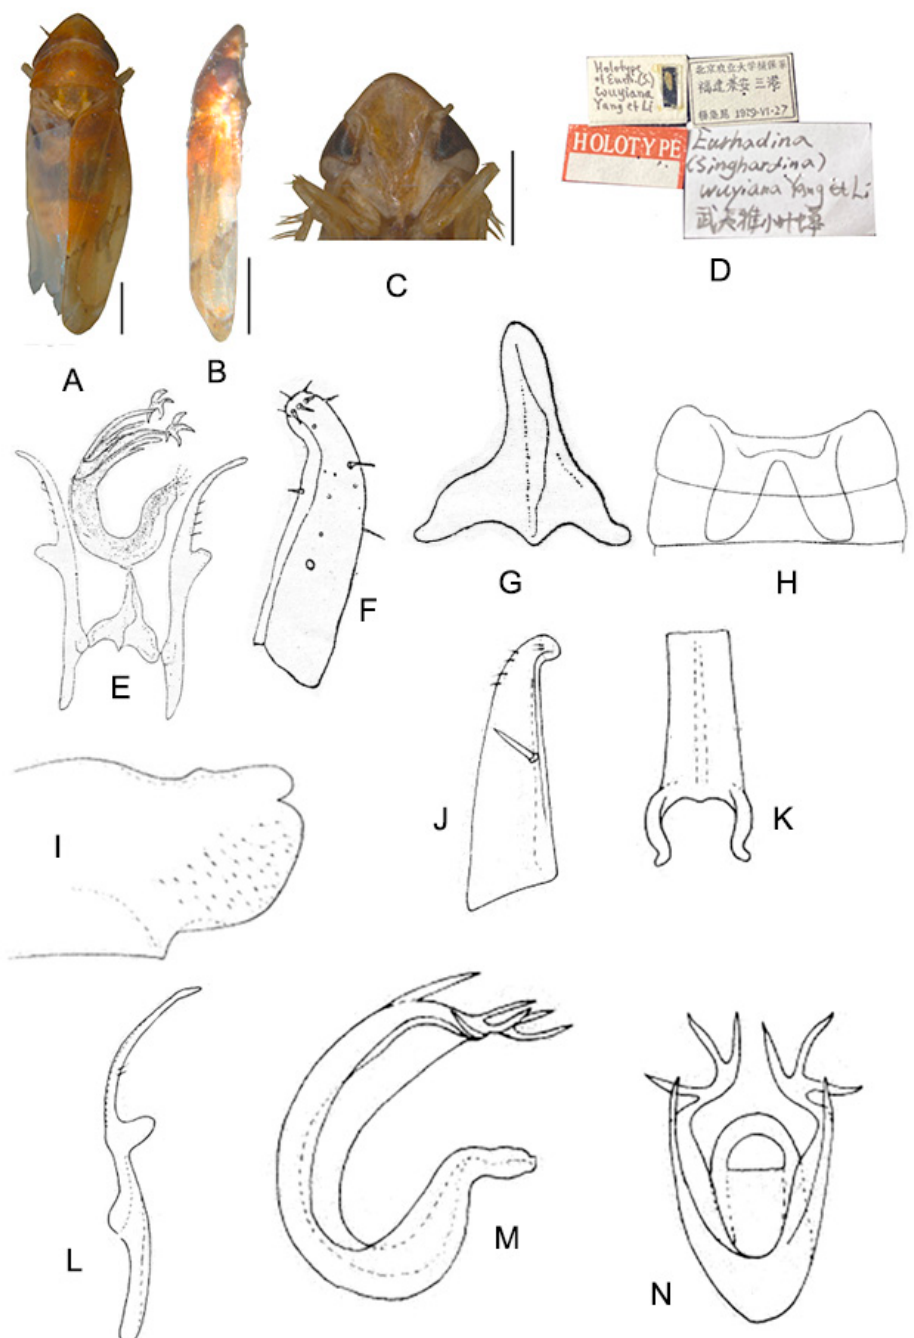
Figure 22. Eurhadina ( Singhardina ) wuyiana ( A – D : holotype; E – G : Yang et Li, 1991 [12]; H–N: Huang et Zhang, 1999 [8]); ( A ) habitus, dorsal view; ( B ) habitus, lateral view; ( C ) face; ( D ) labels of the holotype (China, Fujian Prov., Chongan, Sangang, 1979.VI.27, coll. Jikun Yang); ( E ) aedeagus, connective and paramere, dorsal view; ( F ) subgenital plate, dorsal view; ( G ) connective, dorsal view; ( H ) abdominal apodemes, dorsal view; ( I ) male pygofer side, lateral view; ( J ) subgenital plate, dorsal view; ( K ) connective, dorsal view; ( L ) paramere, dorsal view; ( M ) aedeagus, lateral view; and ( N ) apex of aedeagal shaft, dorsal view. Scale bars: 0.5